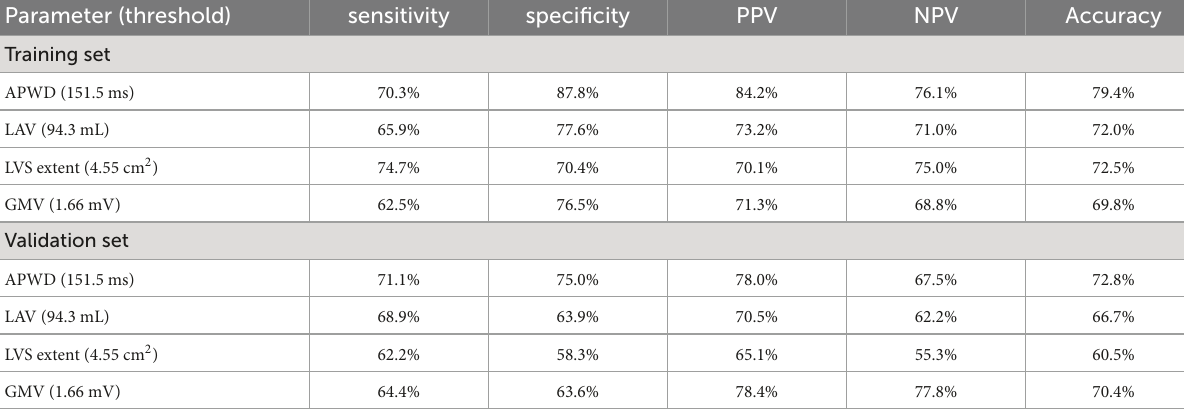
TABLE 4 Diagnostic thresholds of identified predictors for AF